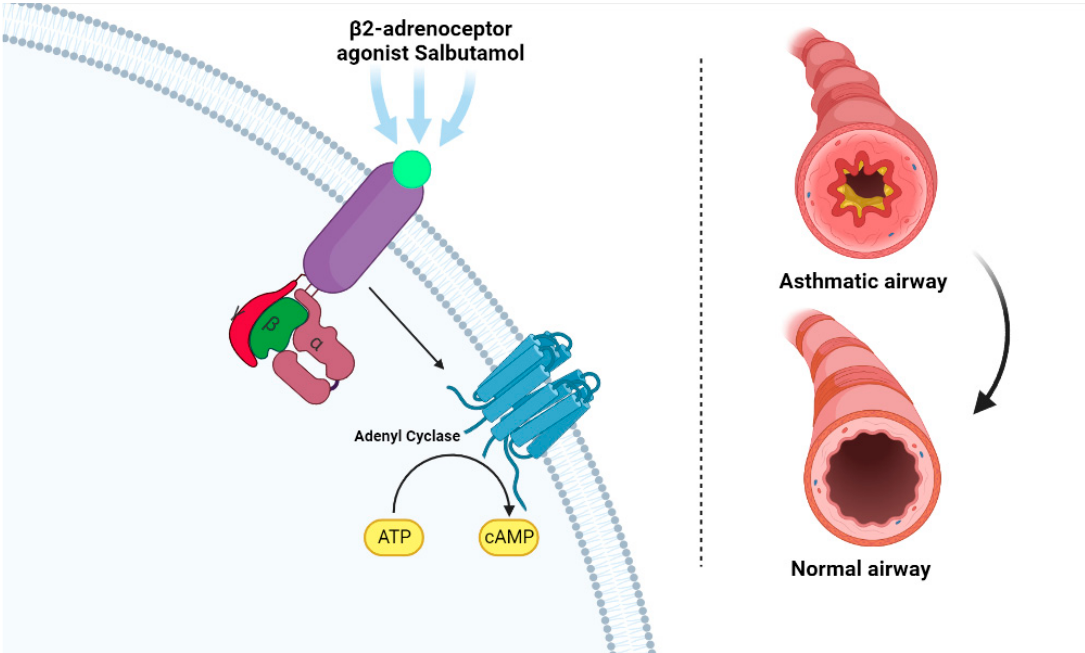
Figure 2. Mechanism of action of salbutamol ( left ). The β 2 -adreneceptor agonist (light green) binds to the β 2 receptor (purple), which activates adenyl cyclase, resulting in the conversion of ATP to cyclic AMP (cAMP). This promotes bronchodilation and relieves symptoms experienced during an acute asthma episode ( right ). Created with Biorender.com. Available online: http://biorender.com/ (accessed on 11 October 2022).